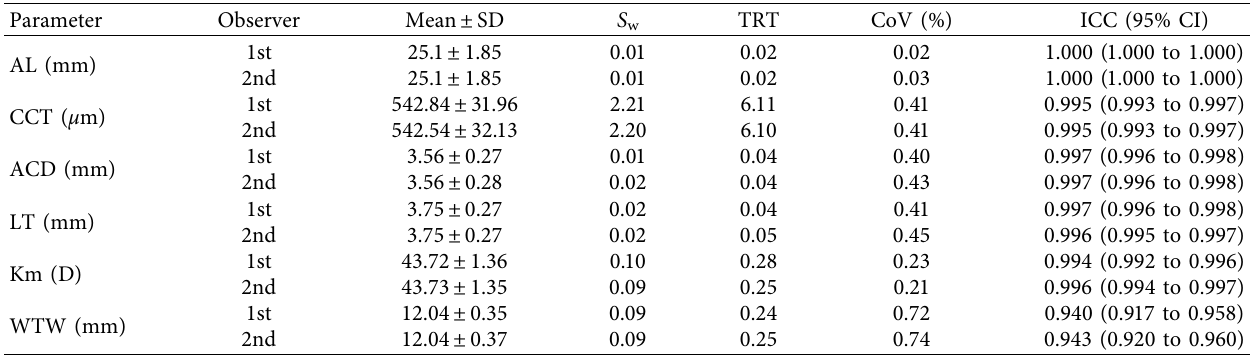
Table 2: Intraobserver repeatability outcomes for biometric measurements obtained using IOLMaster 700 swept-source optical coherence tomography in normal subjects.